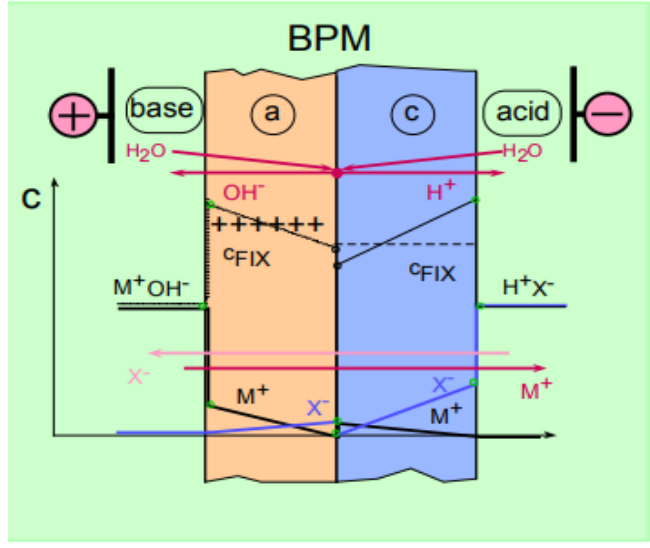
Figure 2. Schematic concentration profiles in a bipolar membrane.